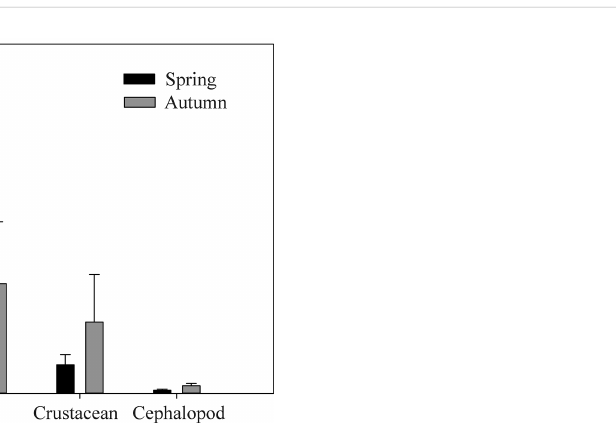
FIGURE 2 Comparison of catch density of fi sh and benthic invertebrates in Weizhou Island of Beibu Gulf in spring and